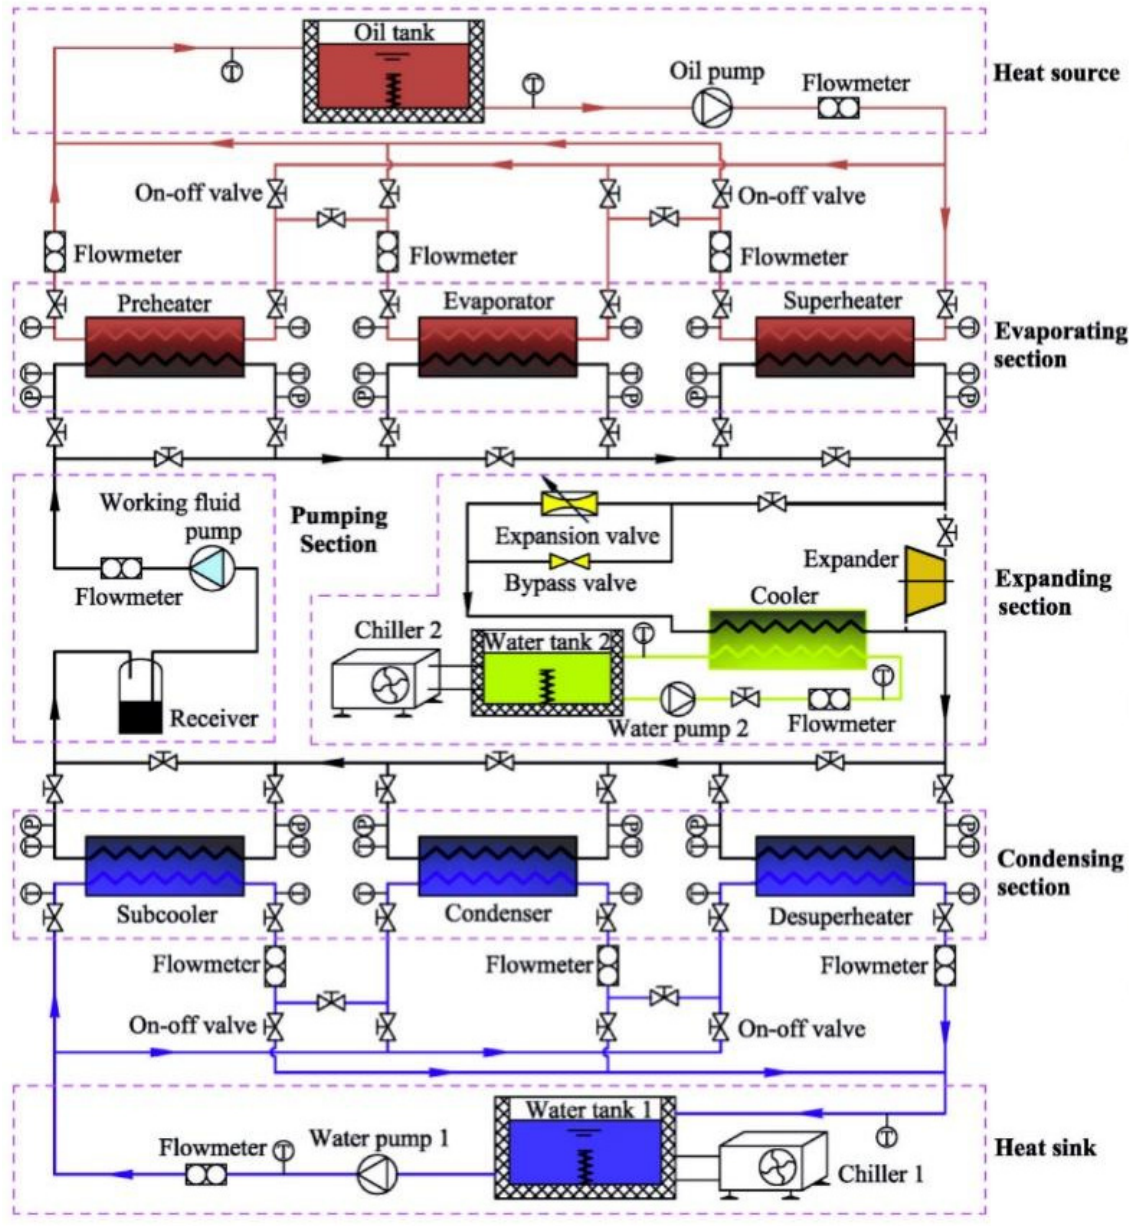
Figure 5. Schematic of the test rig of the ORC system [16]. Reproduced with permission from Chen et al., Energy Conversion and Management; published by Elsevier, 2019.